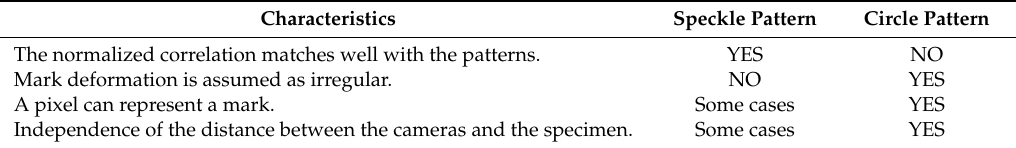
Table 1. The advantages and disadvantages of circle pattern versus speckle pattern. Characteristics Speckle Pattern Circle Pattern The normalized correlation matches well with the